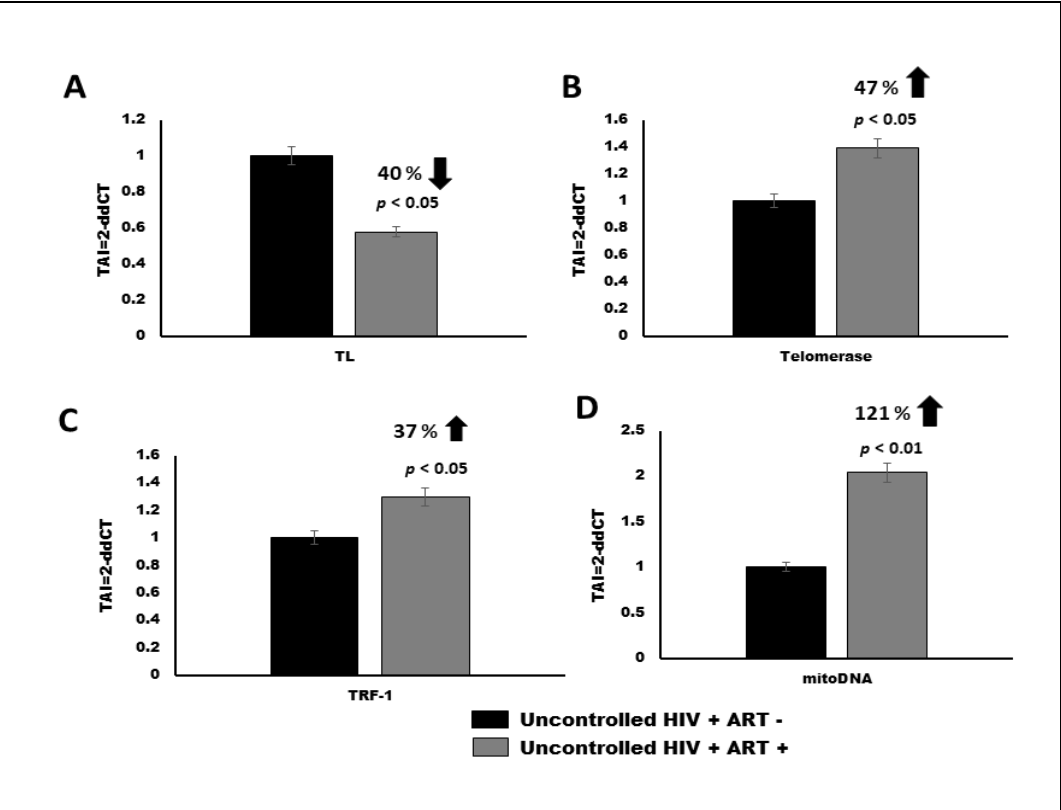
Figure 1. ( A – D ): Quantitation of telomere length, telomerase, TRF-1 gene expression and mtDNA by QPCR between HIV positive patients with uncontrolled infection who were on cART vs. treatment naïve patients. Results are expressed as the mean ± SD from a total of ( n = 10 subjects/group). A p value of <0.05 is considered a statistically significant difference.